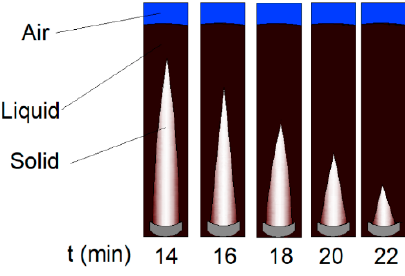
Figure 4. Melting process of a PCM inside a vertical cylinder, adapted from Katsman et al. [62].